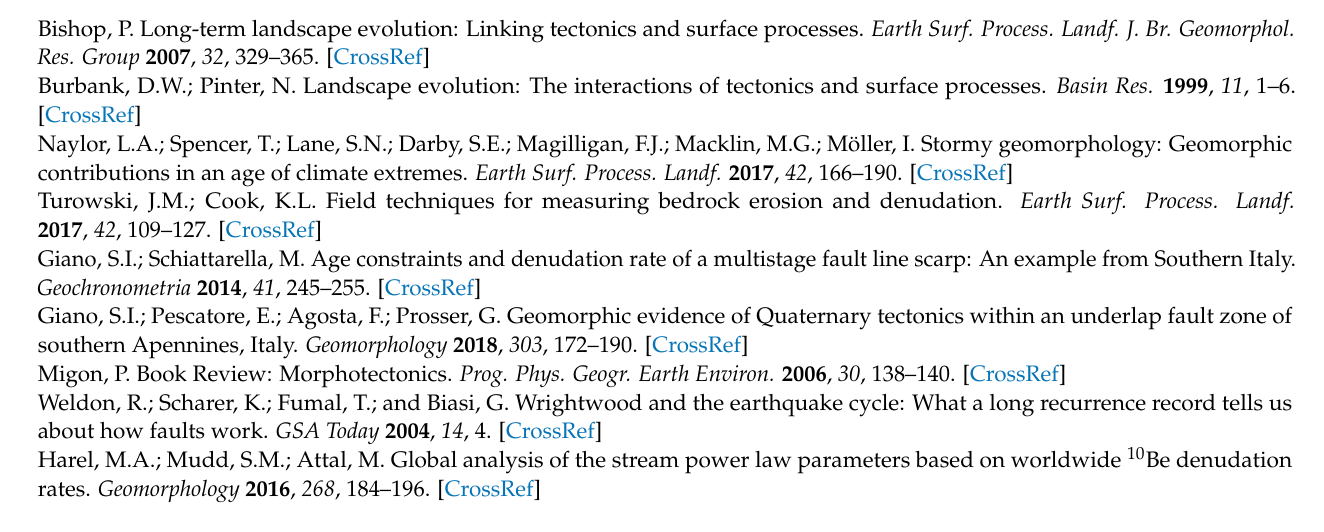
Table S1: Material and components characteristics, Supplement 3- Movie of the analog experiments, Movie S3 : Creep-2-b and Movie S4 :